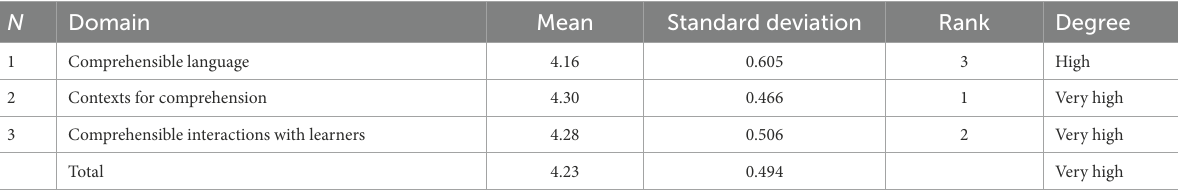
TABLE 6 Descriptive analysis of language comprehensibility